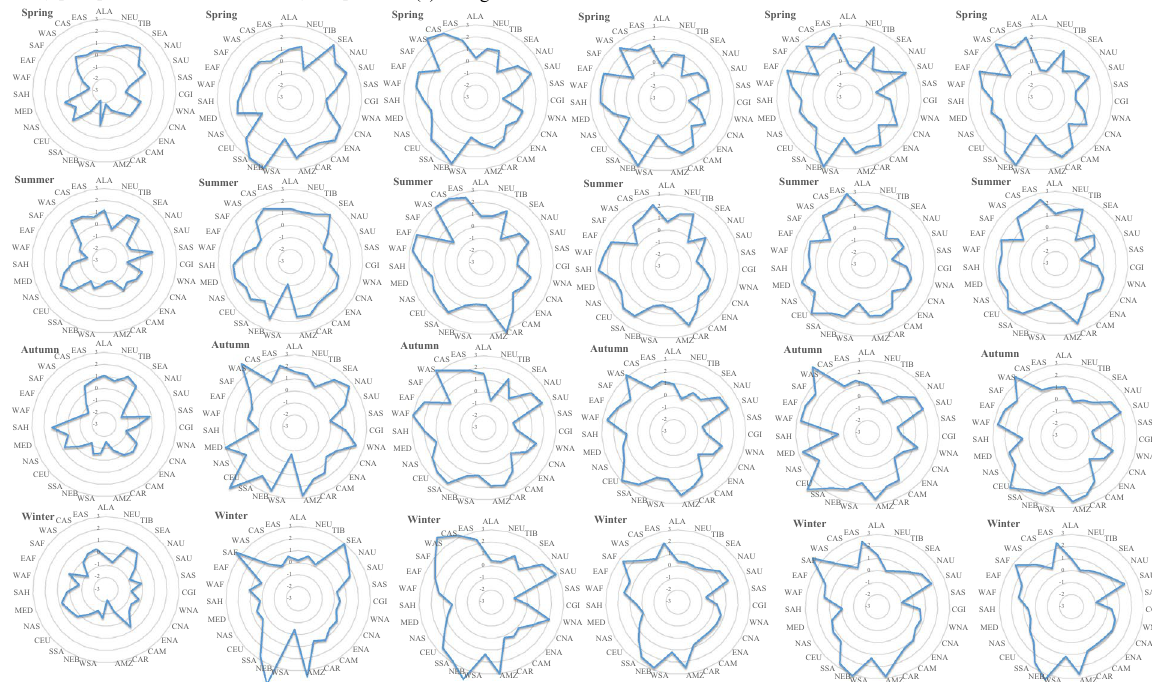
Fig. 11 Different seasonal trends on six continents for the six wildfire-related variables. This figure shows the long-term trends over four seasons for six fire-related variables across 27 climate reference regions. The numbers in the figure are the Z values in the TFPW-MK test. The trend categories according to the Z values are: [1.96, ), significant increasing trend; [1.64, 1.96), weak increasing trend; [0, 1.64), no significant increasing trend; +∞ (-1.64, 0), no significant decreasing trend; (-1.96, -1.64], weak decreasing trend; (-